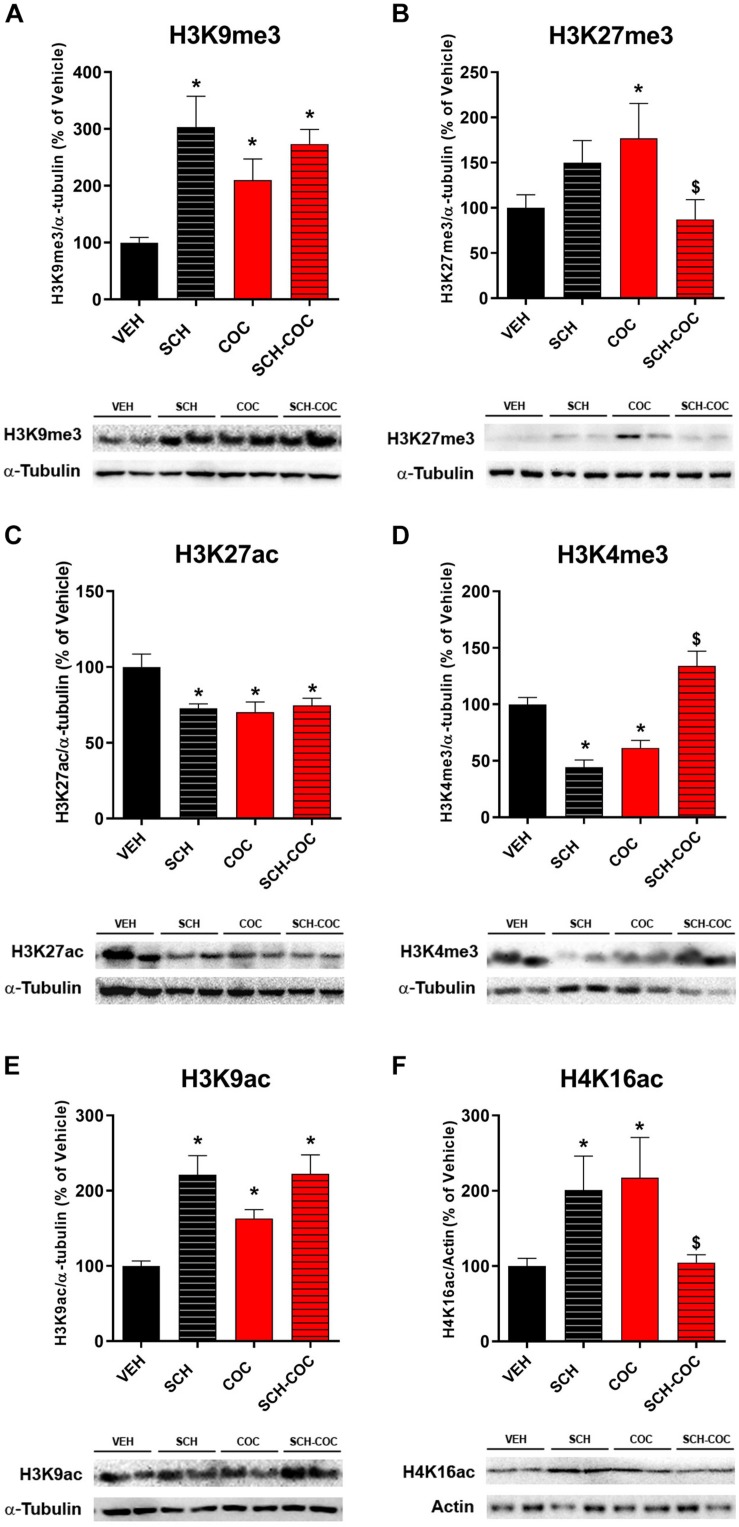
Effect of cocaine (COC), SCH23390 (SCH), and SCH 15 min before COC (SCH-COC) treatments on H3 and H4 post-traslational modifications expression in male germ cells. Protein expression levels (western blot) of (A) H3K9me3, ANOVA-Bonferroni F(3,20) = 6.87, p = 0.004. (B) H3K27me3, Kruskal–Wallis-paired comparisons H = 7.93, p = 0.047. (C) H3K27ac, ANOVA-Bonferroni F(3,20) = 8.86, p = 0.0009. (D) H3K4me3, ANOVA-Bonferroni F(3,23) = 23.84, p < 0.0001. (E) H3K9ac, Kruskal–Wallis-paired comparisons H = 13.5, p = 0.004. (F) H4K16ac, Kruskal–Wallis-paired comparisons H = 12.6, p = 0.005. Values indicate mean ± SEM (n = 5–7). *p < 0.05 different from VEH, $p < 0.05 different from COC.